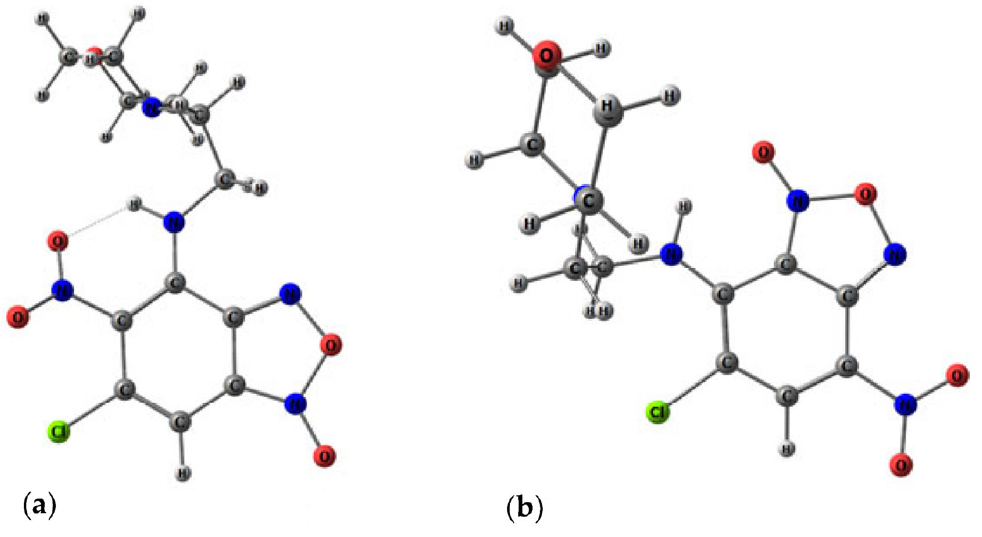
infinitely distant from each other), accompanied by the removal of hydrogen chloride.